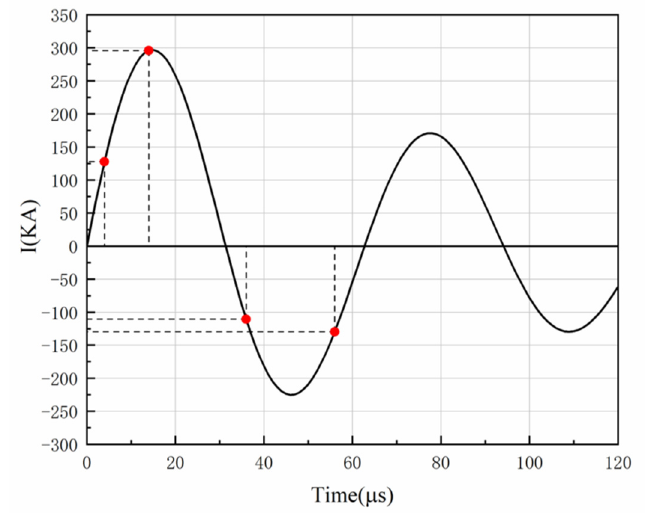
Figure 4. Output current waveform with discharge voltage of 14 KV.